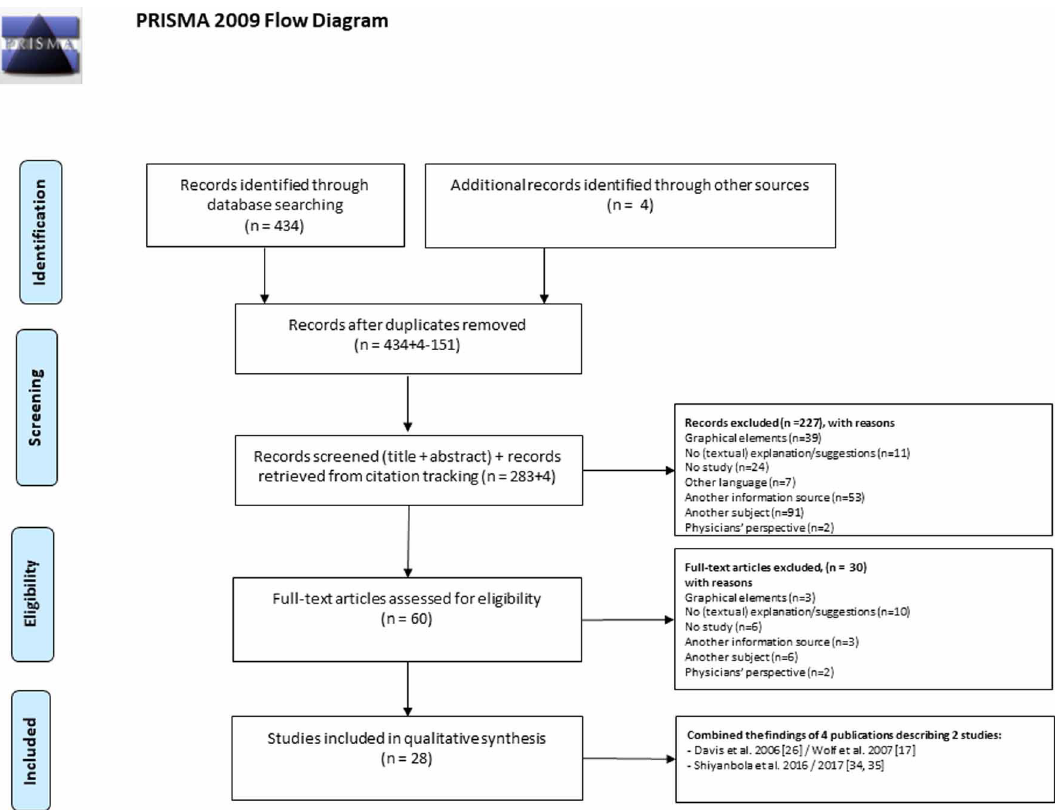
Fig 1. Flow chart of the selection of studies about DLIs included in the